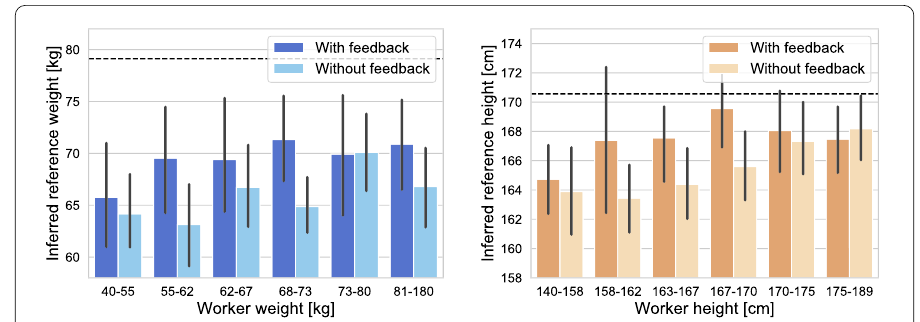
Figure 23 Reference values inferred for the setups with and without feedback, for workers from Asia only. Dashed lines denote the true mean weight/height over all images